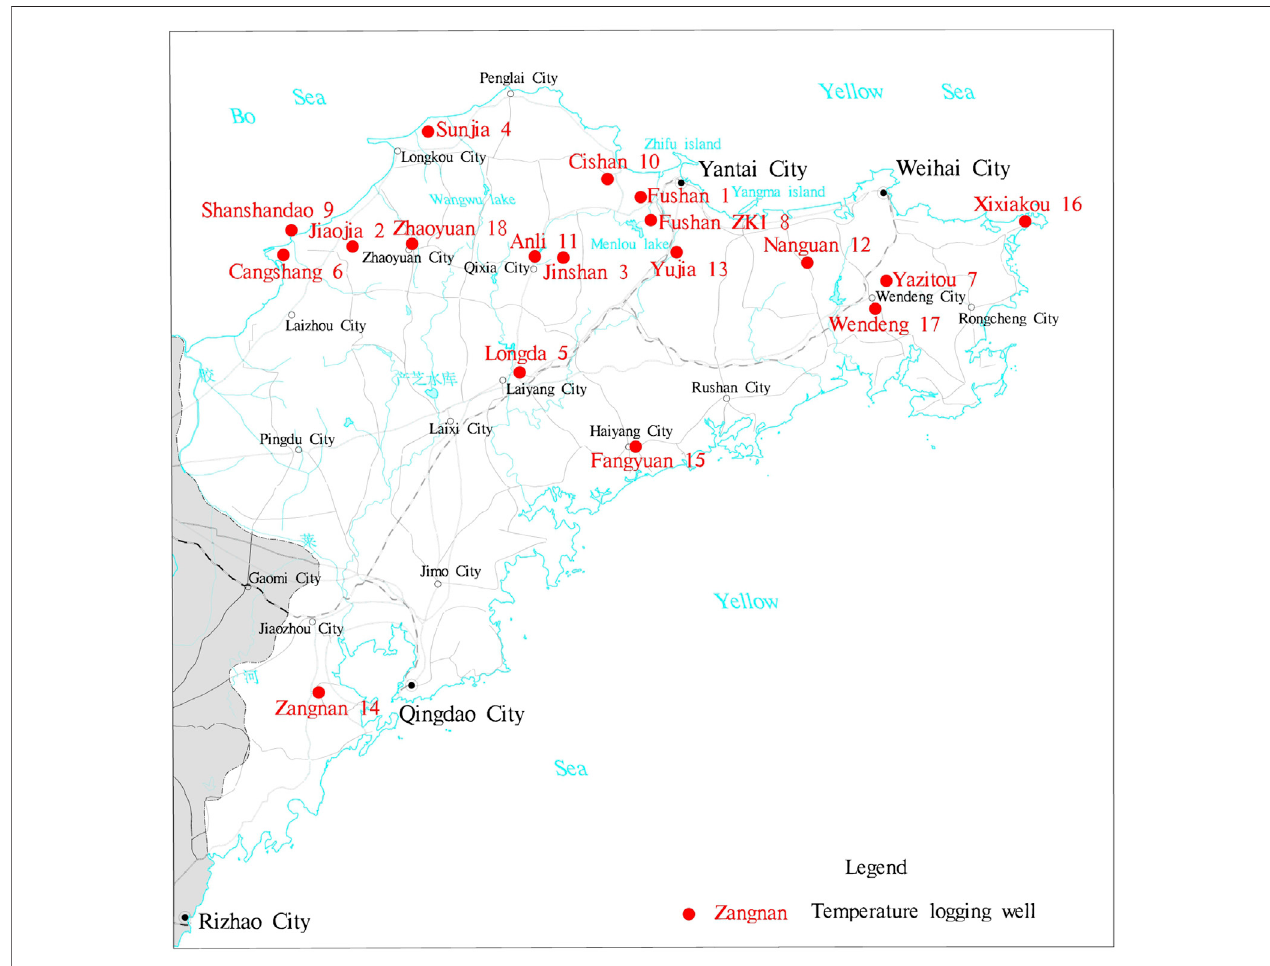
FIGURE 5 | Locations of the temperature logging wells ( Figure 6